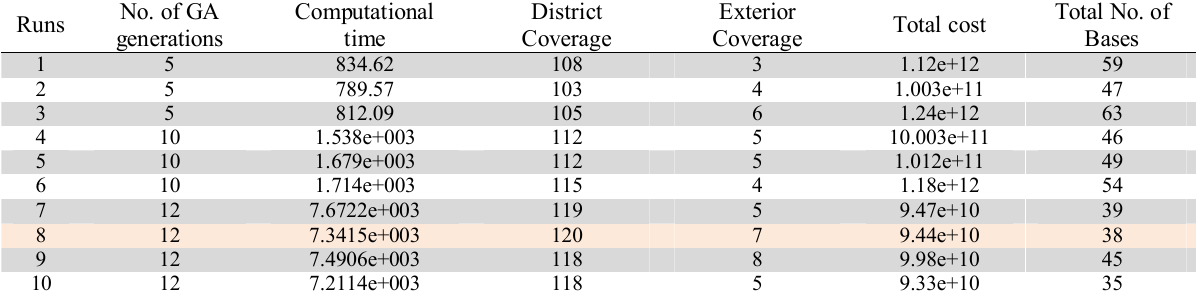
Summary of results for different GA runs